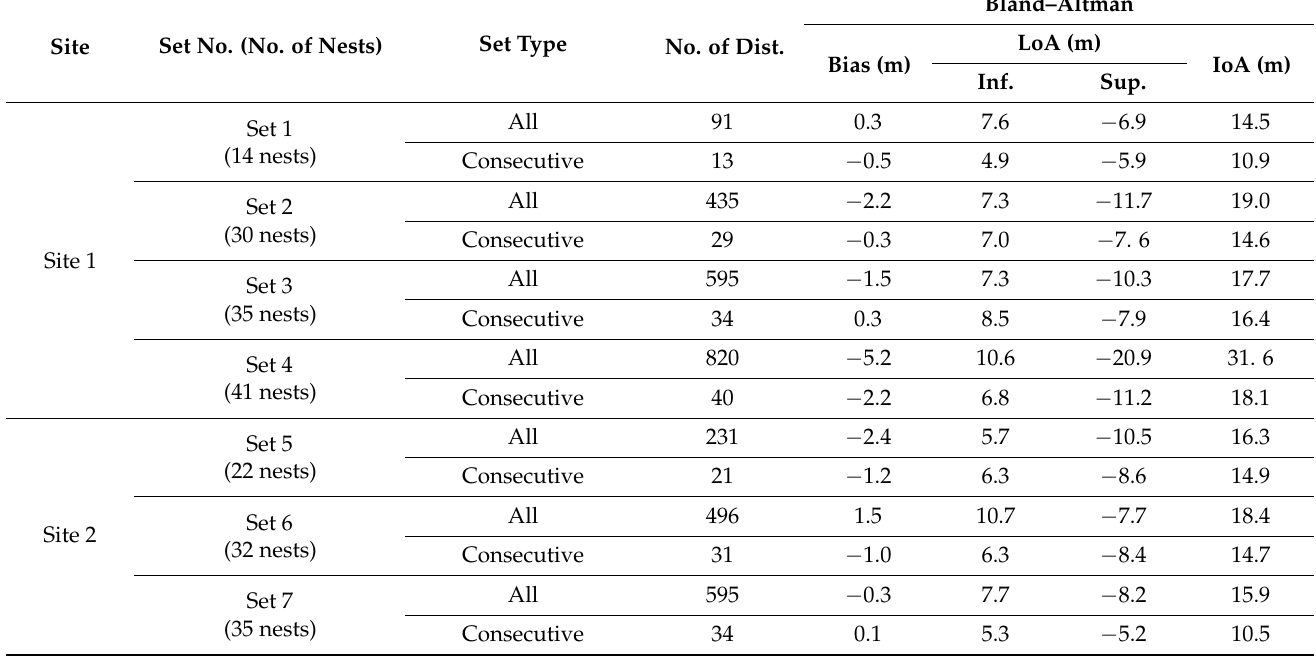
Table 1. Results of the Bland–Altman analysis for the separate sets of nests included in the study (“all”—all possible distances between any two nests; “consecutive”—only distances between consecu- tive nests along the track; LoA—limits of agreement; IoA—interval of agreement; no. of dist.—number of distances between two